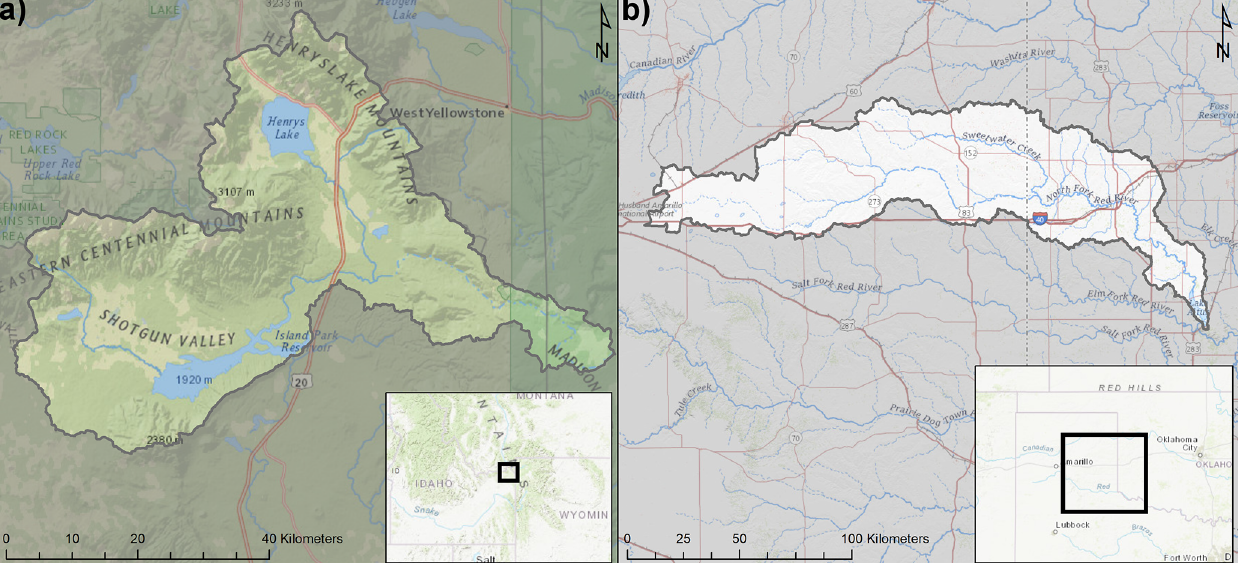
Figure 2. Island Park (a) and Altus (b) watershed locations. Base layers are from © Esri (Environmental Systems Research